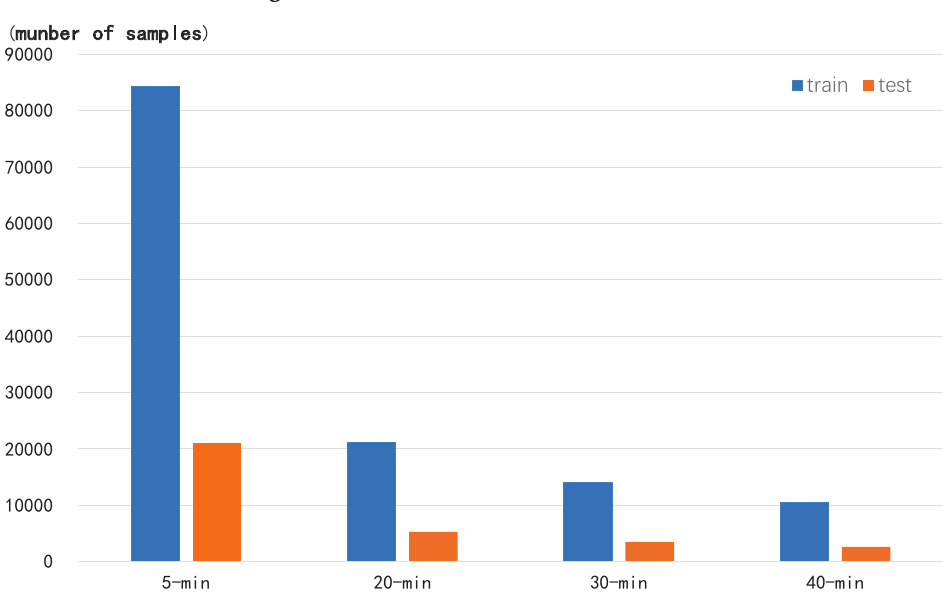
Figure 6. The distribution of raw data values.